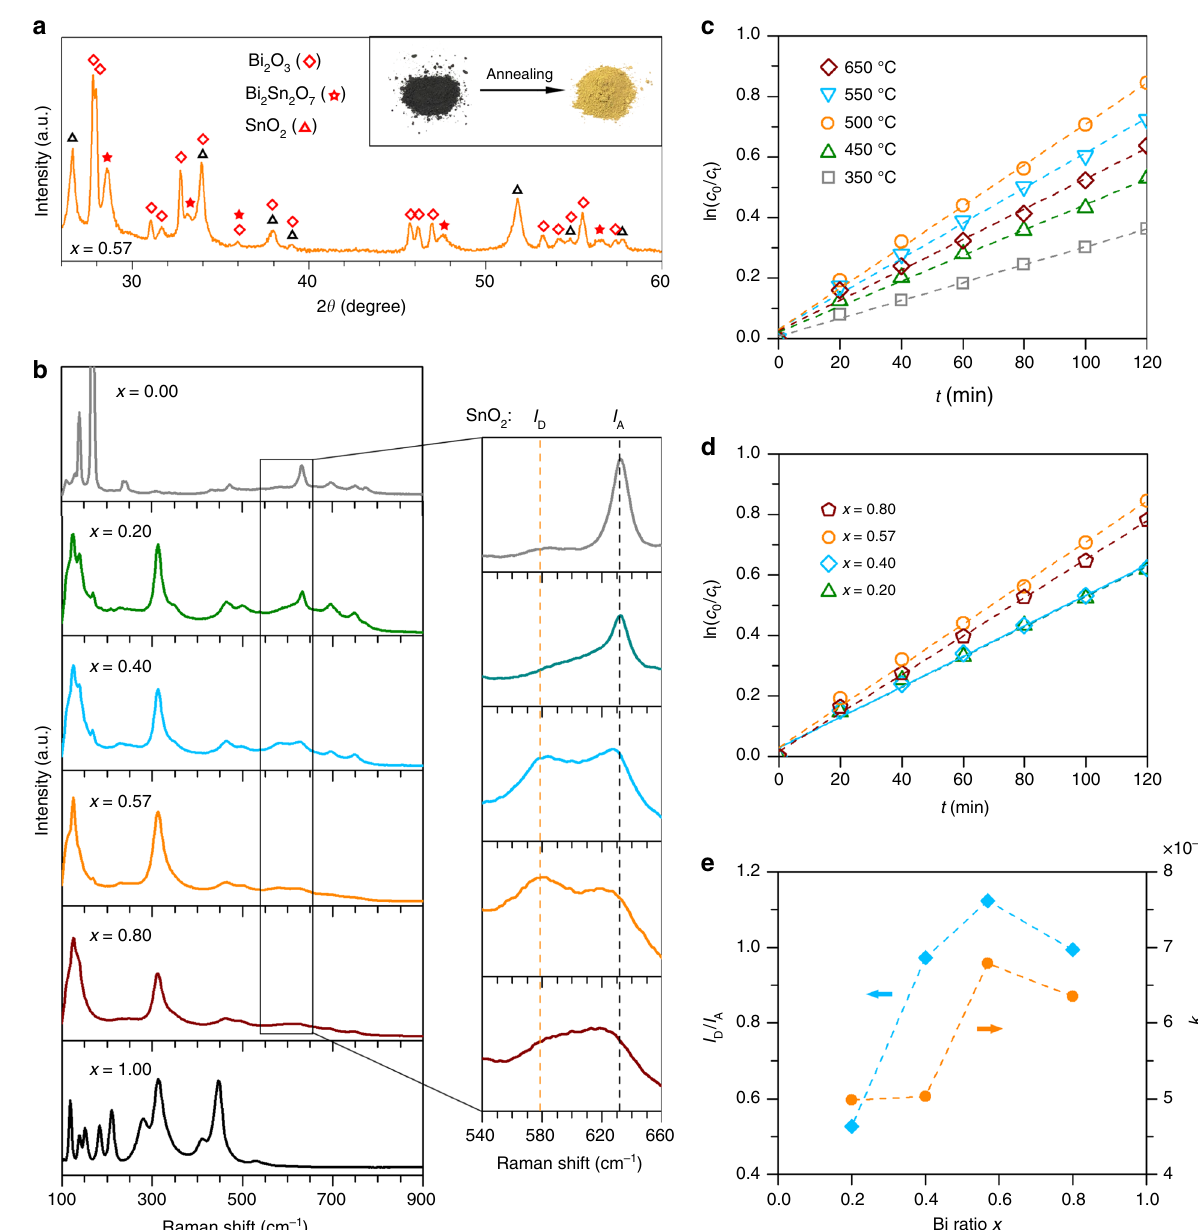
Fig. 7 Characterisation and photocatalytic activity of the annealed Bi x Sn 1 − x nano-alloys. a XRD patterns of the eutectic sample after annealing at 500 °C for 1 h. The inset shows the colour of the eutectic sample before and after annealing. b Raman spectra of the Bi – Sn nano-alloys annealed at 500 °C for 1 h. The magni fi ed regions show the relative intensity of the SnO 2 defect mode I D and active mode I A . c Plots of ln ( c 0 / c t ) vs. t for the eutectic samples annealed at different temperatures. d Plots of ln ( c 0 / c t ) vs. t for the Bi – Sn nano-alloy samples annealed at different 500 °C for 1 h. e The dependence of SnO 2 defect intensity (characterised by I D / I A ) and dye degradation rate constant k on the mixing ratio of the Bi – Sn nano-alloy